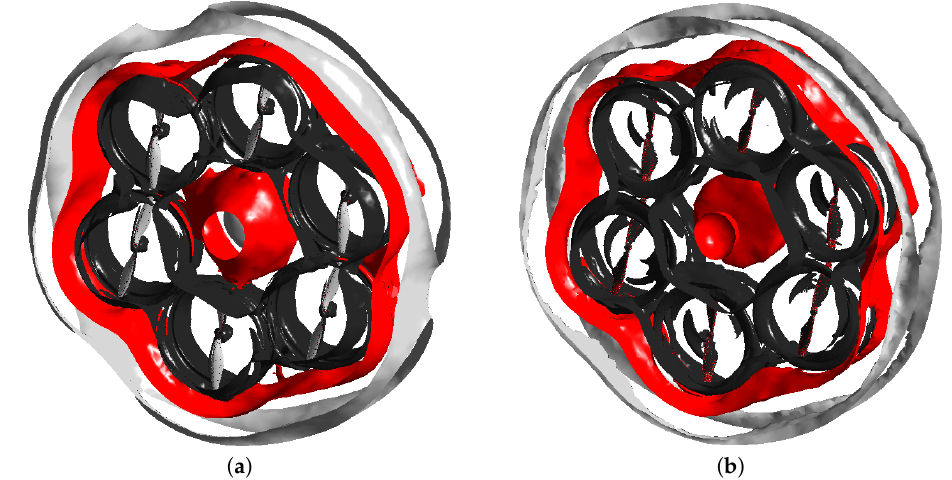
Figure 3. Isosurface visualisation of the field parameter distribution: ( a ) velocity magnitude—0.3, 1.0, 3.0 m/s (grey, red, black); ( b ) turbulence intensity—1, 5, 14% (grey, red,